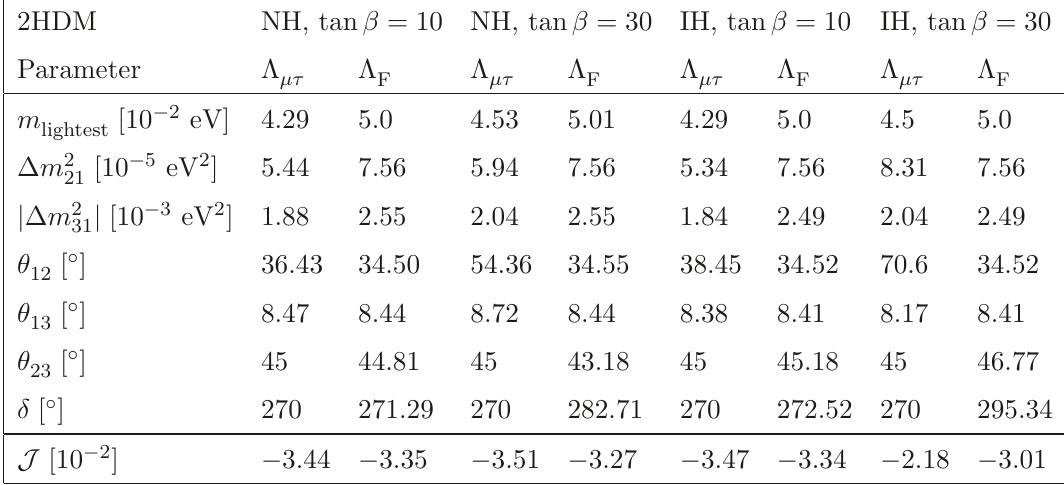
Table 2 . An illustration of the neutrino oscillation parameters at Λ with tan β = 10 or 30, where both NH and IH cases are